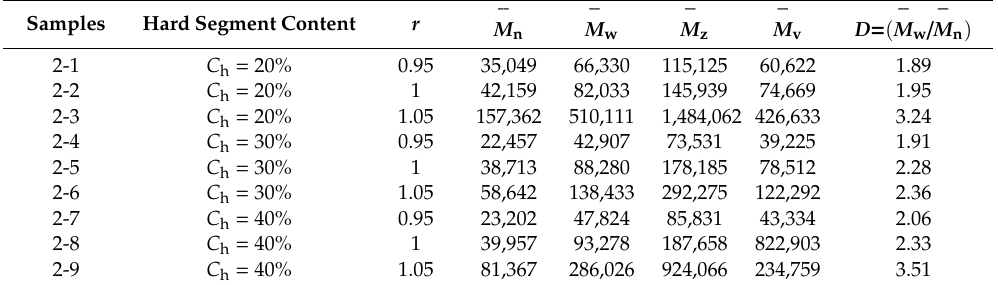
Table 6. Influence of di ff erent hard segment content and r on molecular weight of polyether-based TPUs. Samples